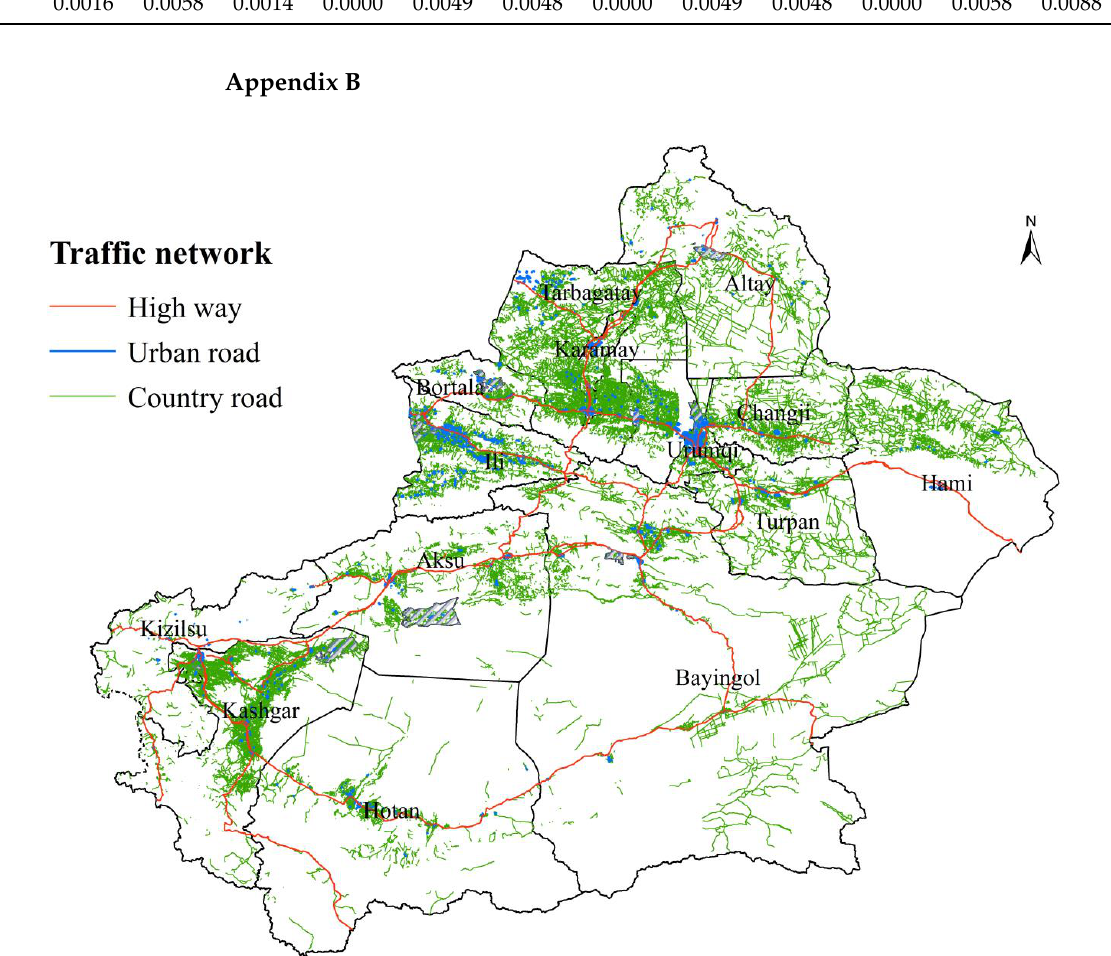
Figure A1. Xinjiang Oasis Regional Geographical Conditions Monitoring data: road network data.